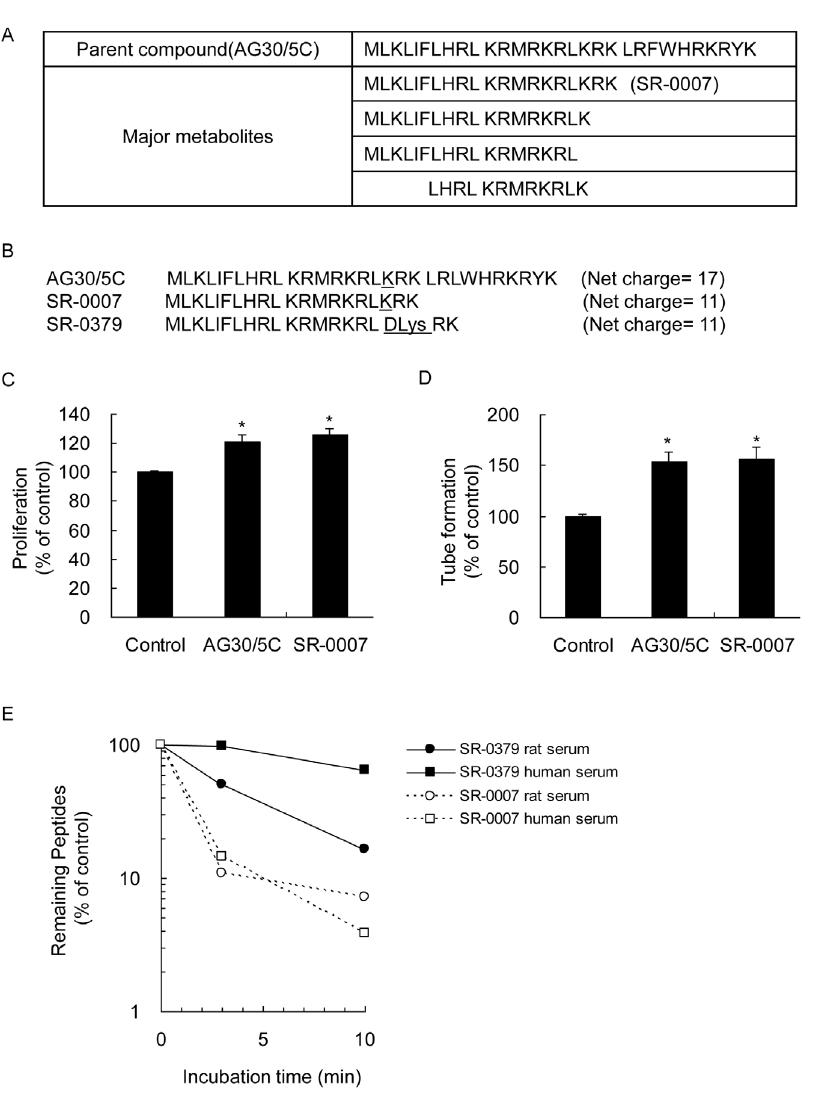
Figure 1. Lead optimization from the angiogenic peptide AG30/5C. A) Major metabolites of AG30/5C determined by MALDI-TOF MS. The parent compound (AG30/5C) was incubated with rat serum in vitro 60 minutes. The metabolites were identified by comparison with the pre- incubation peptide. B) Sequences and net charges of AG30/5C and AG30/5C-derived peptides (SR-0007 and SR-0379). The lysine (K) of SR-007 was replaced with D-lysine in SR-0379. C) Effect of AG30/5C (10 m g/ml) and SR-0007 (10 m g/ml) on HUVECs proliferation. N=3 per group. *P , 0.05 vs. control. D) Effect of AG30/5C (10 m g/ml) and SR-0007 (10 m g/ml) on tube formation. The formation of capillary-like structures was observed in co- cultures of HUVECs and NHDFs. N=5-12 per group. *P , 0.05 vs. control. E) Stability of SR-0007 and SR-0379 in rat and human sera. SR-0007 and